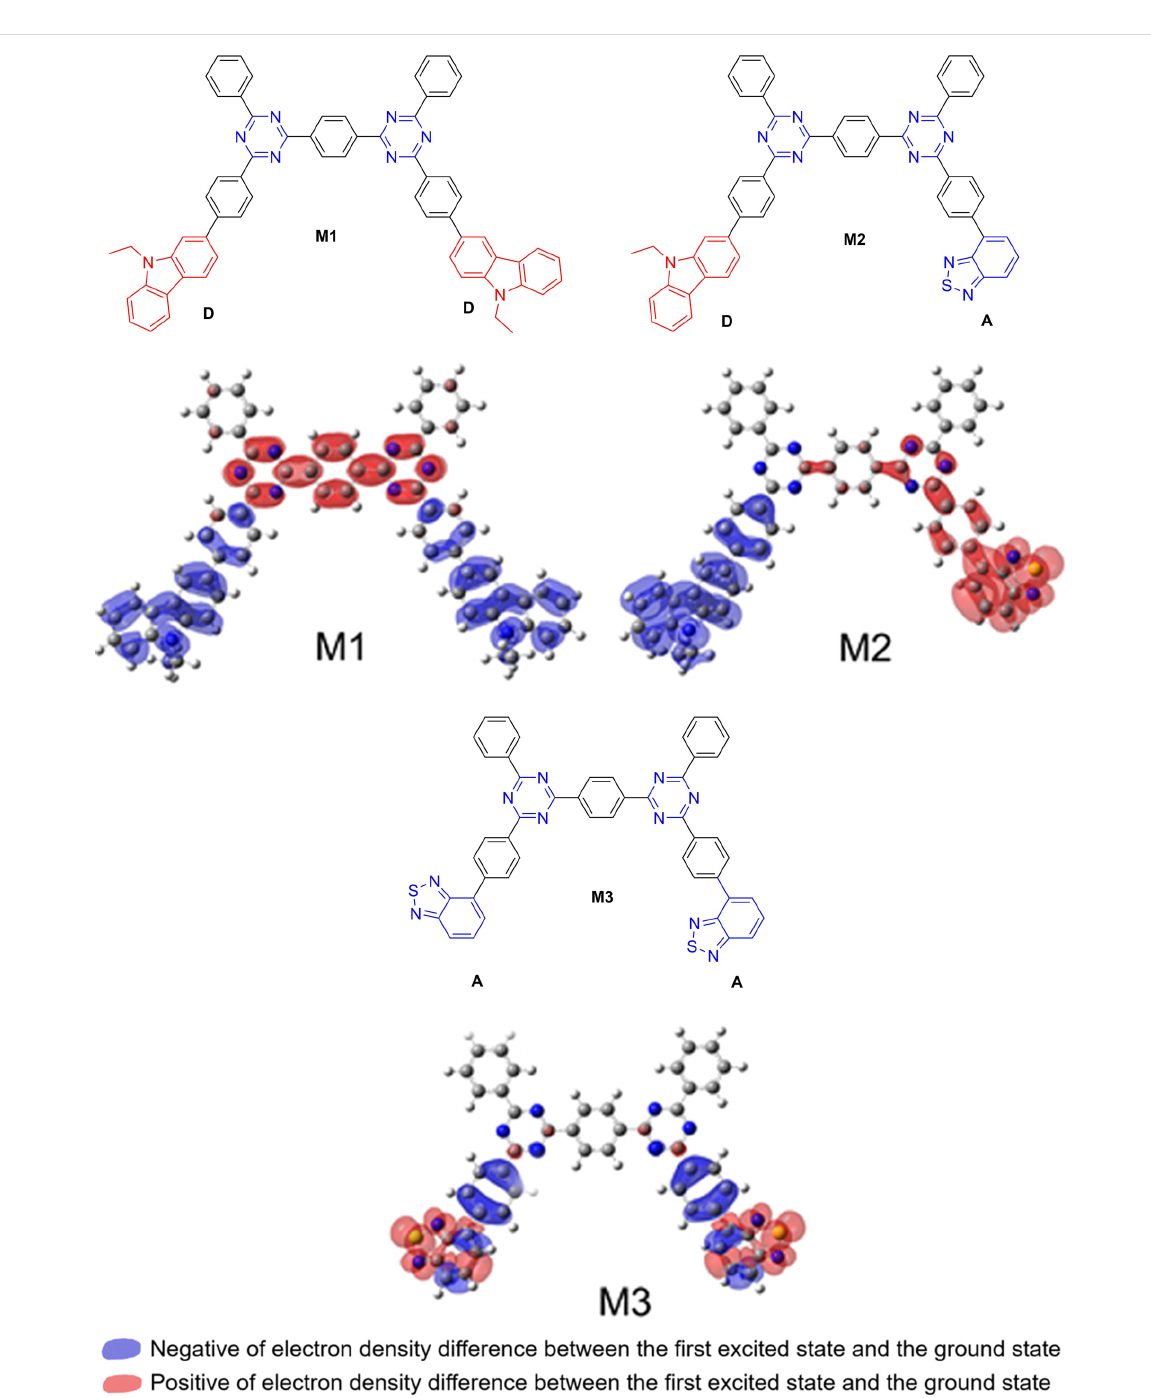
fragment were prepared to make comparisons, that is, the 1,3,5- tri(pyridin-2-yl)benzene based COF P13 and the benzene- triazine-based P14 (Figure 4). Both of them showed a similar AA eclipsed stacking in the crystal structures, but the lower symmetry of P13 resulted in worse crystallinity. Particularly,